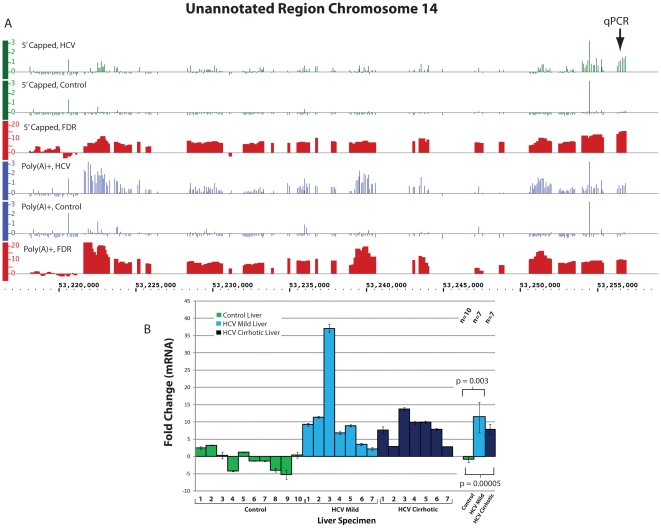
Differential expression of a Pol II RNA from an unannotated region of
Chromosome 14.
Panel A. Expression of 5′ capped and poly(A)+ RNAs as
measured by signal intensity on ENCODE tiling arrays are displayed using
IGB. The data is displayed as in Figure 2 except that each tick mark
represents the normalized mean signal intensity of probes within a 200 nt
window. Panel
B. qPCR was performed as described in Methods. Triplicate samples from seven HCV cirrhotic,
seven mild HCV (no fibrosis) and ten control livers were analyzed. HCV
cirrhotic 1 and Control 1 refer to original samples used for the ENCODE
tiling array analysis. The mean ± SEM fold change for all specimens
analyzed is shown and the location of the qPCR primers is indicated by qPCR
in Panel A.